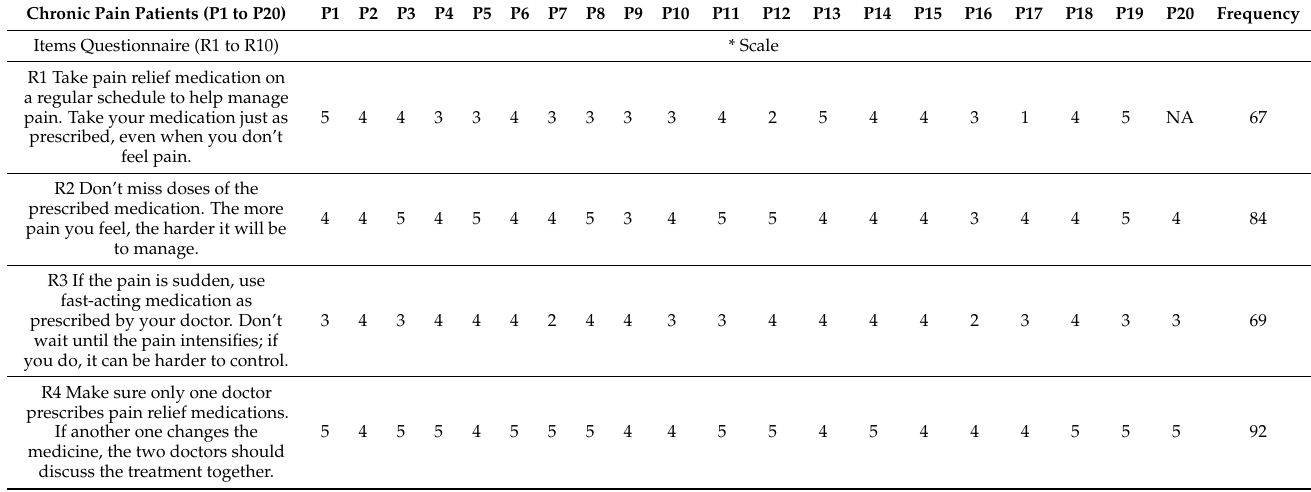
Table 6. Degree to which pharmacological recommendations can improve